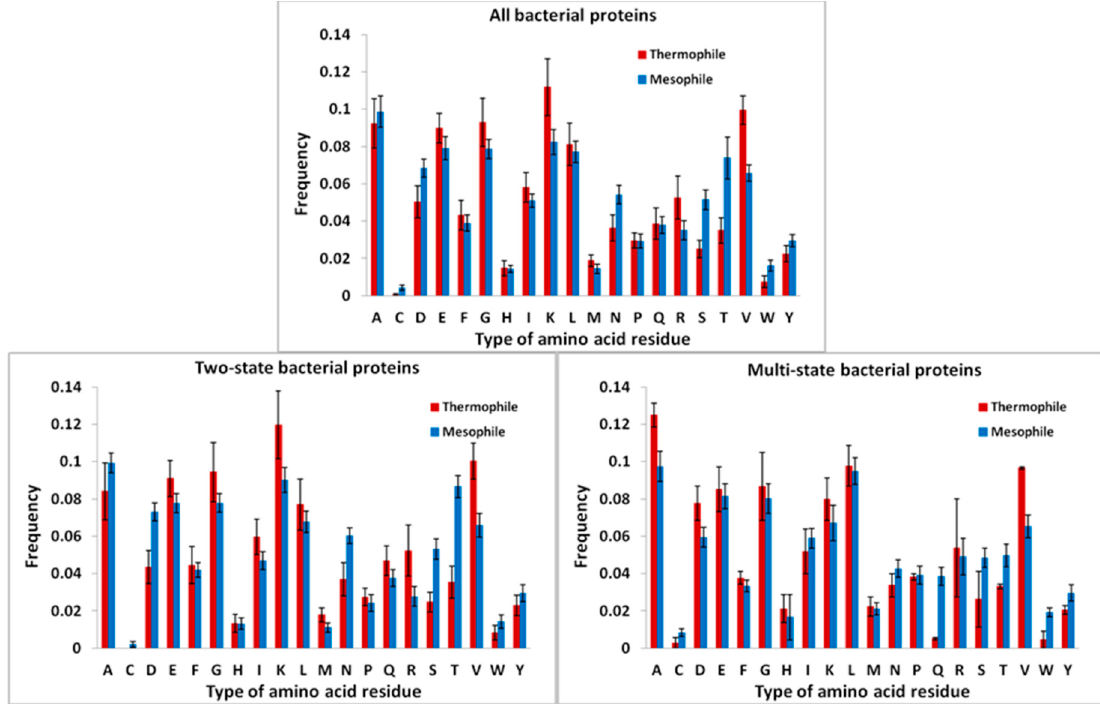
Figure 9. Amino acid composition of the bacterial thermophilic and mesophilic proteins with two- and multi-state kinetics.